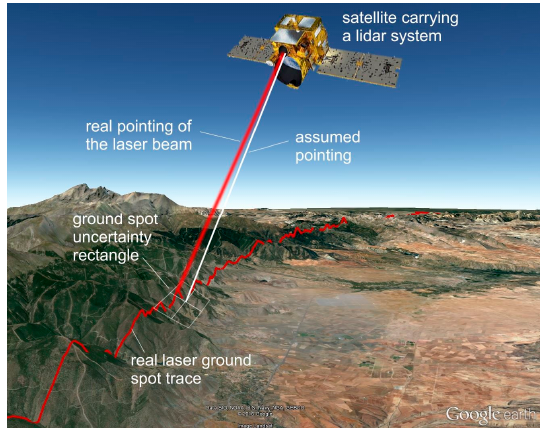
Figure 1. Illustration of lidar pointing geometries (not to scale). A ground spot uncertainty rectangle is spanned by uncertainties in the laser pointing (roll and pitch). The ground elevation information along the ground spot trace, derived from the lidar measurements, can be used for matching with the external topography data to geo-reference the real ground spot trace, which allows for the derivation of the real roll and pitch angles. (Background picture: © 2016 Google, satellite: MERLIN, © CNES). The requirements depend strongly on the purpose and type of the lidar system. For example, for spaceborne CO 2 measurements, severe pointing knowledge stabilities of 66 μ rad were specified to be met for a sufficient consideration of the Doppler shift (with respect to the measurement error budget) in the framework of the A-SCOPE studies (advanced space carbon and climate observation of planet earth) [11,13,14]. In case of CH 4 soundings, error budget analyses for the MERLIN mission (methane remote sensing lidar mission) [5,6] imply relaxed pointing stability requirements on the order of 400 μ rad [15] due to the spectral properties of methane in the 1.64 μ m spectral domain [16]. In this paper, an approach for the quantification of lidar pointing deviations from the assumed pointing is described and demonstrated by using experimental data from airborne measurements.